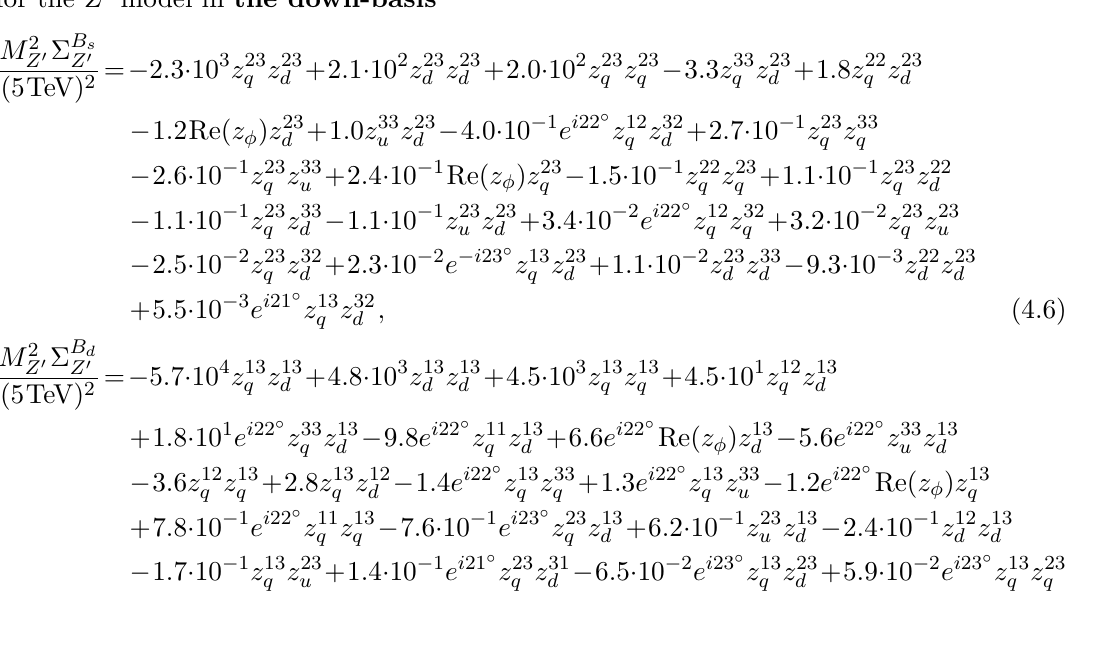
Figure 12 . The maximal NP scale Λ for (cid:2) (cid:3) M ij / (∆ M ij ) exp for B s (blue), B d (red) and K 0 (green), 2 12 BSM